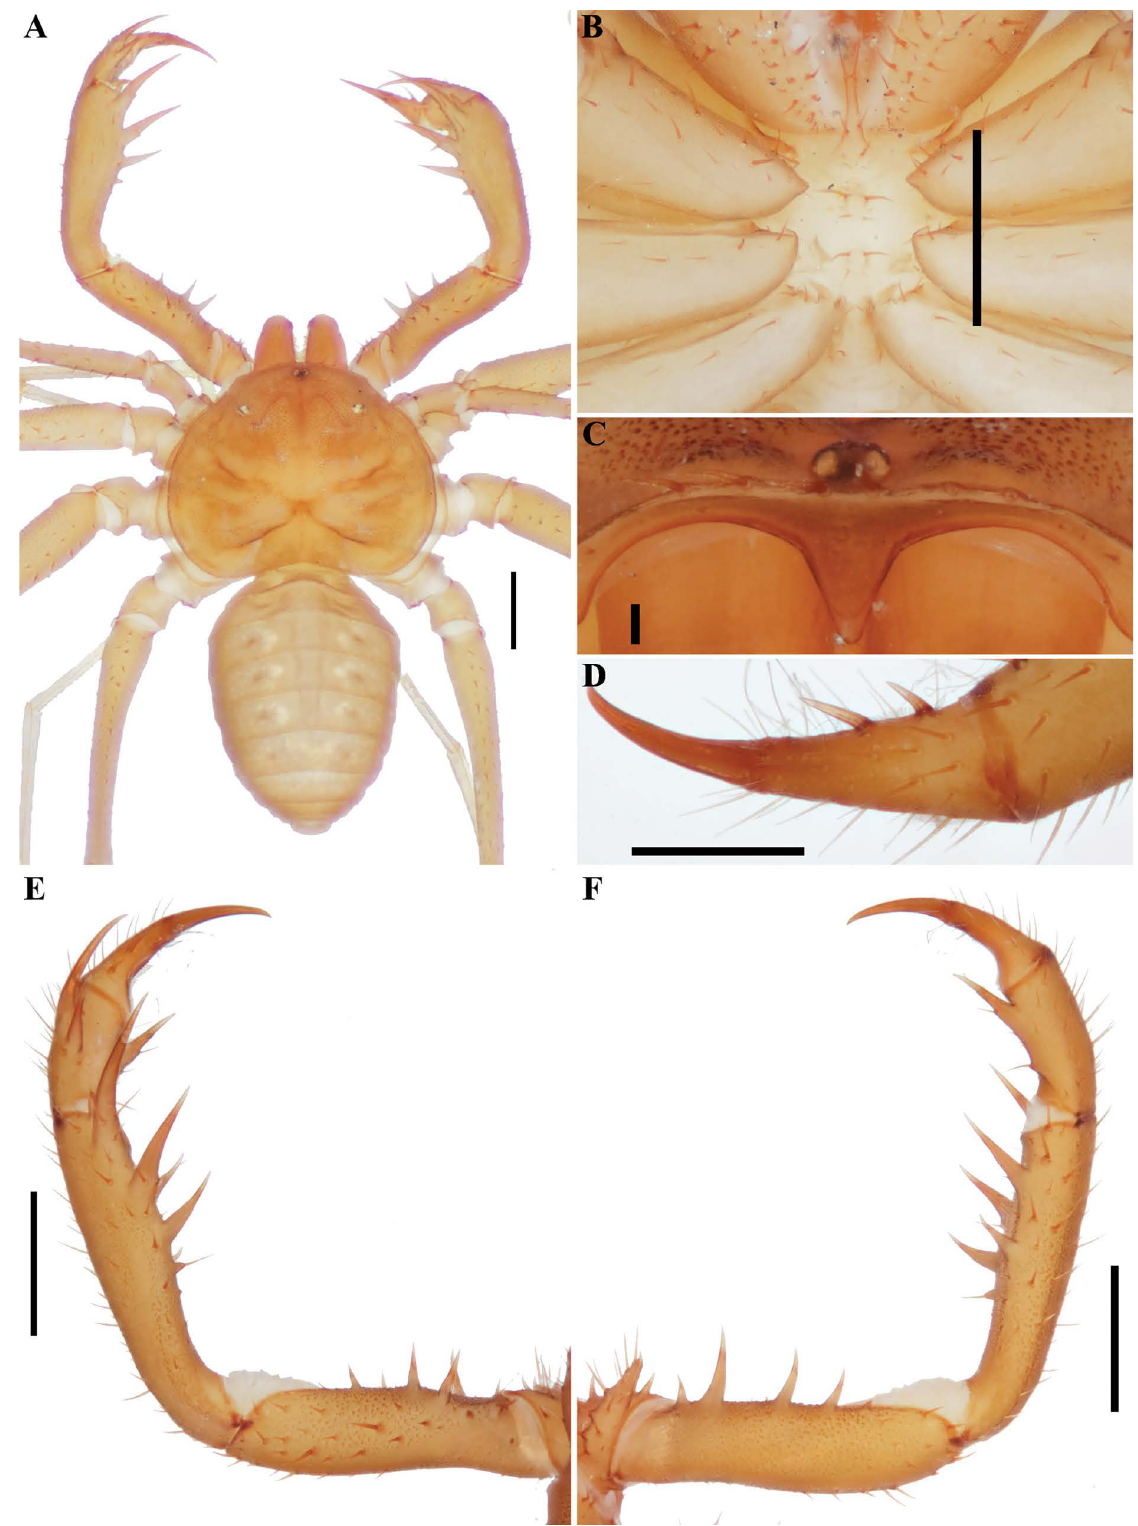
Fig. 78. Charinus una sp. nov. (MNRJ 9131), general morphology, ♂. A . Habitus, dorsal view. B . Sternum, ventral view. C . Frontal process. D . Pedipalp tarsus, frontal view. E . Pedipalp, dorsal view. F . Pedipalp, ventral view. Scale bars: A–B, E–F = 1 mm; C = 0.1 mm; D = 0.5